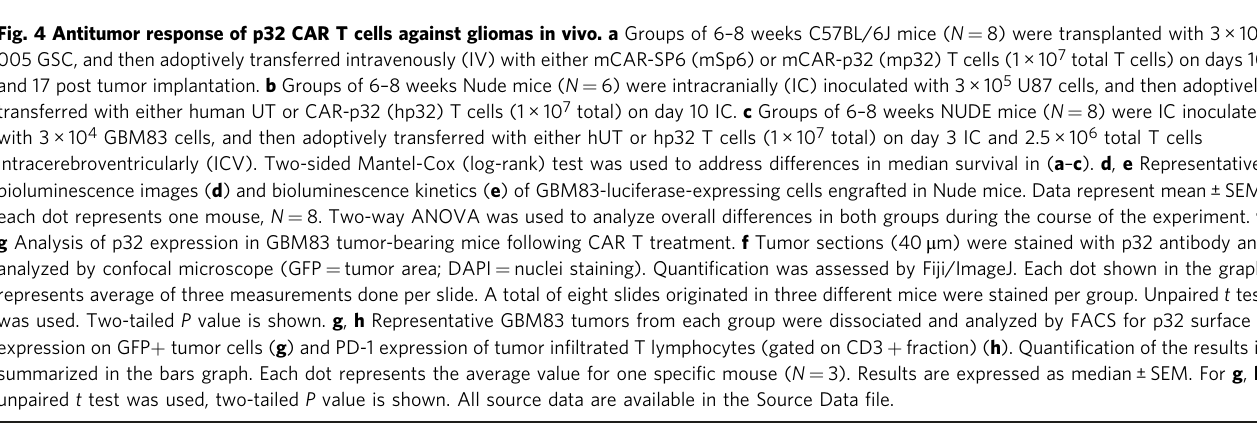
Fig. 4 Antitumor response of p32 CAR T cells against gliomas in vivo. a Groups of 6 – 8 weeks C57BL/6J mice ( N = 8) were transplanted with 3 × 10 5 005 GSC, and then adoptively transferred intravenously (IV) with either mCAR-SP6 (mSp6) or mCAR-p32 (mp32) T cells (1 × 10 7 total T cells) on days